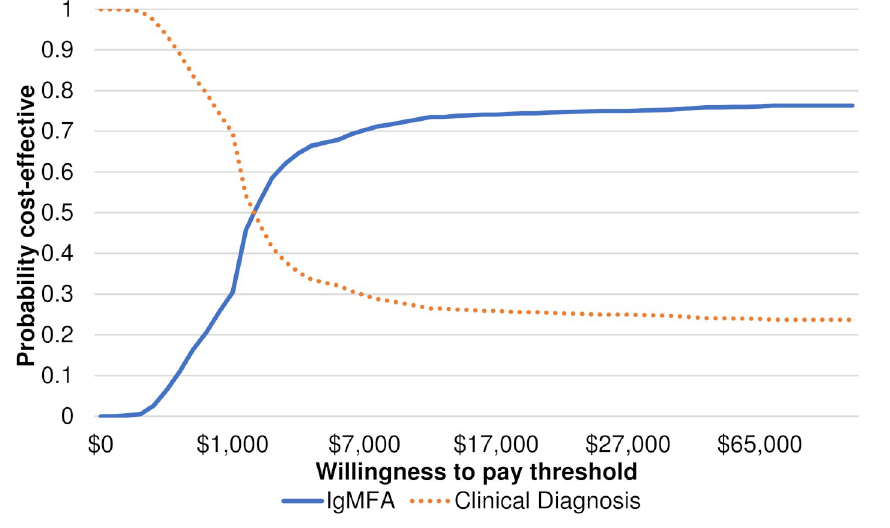
Fig 5. Cost-effectiveness acceptability